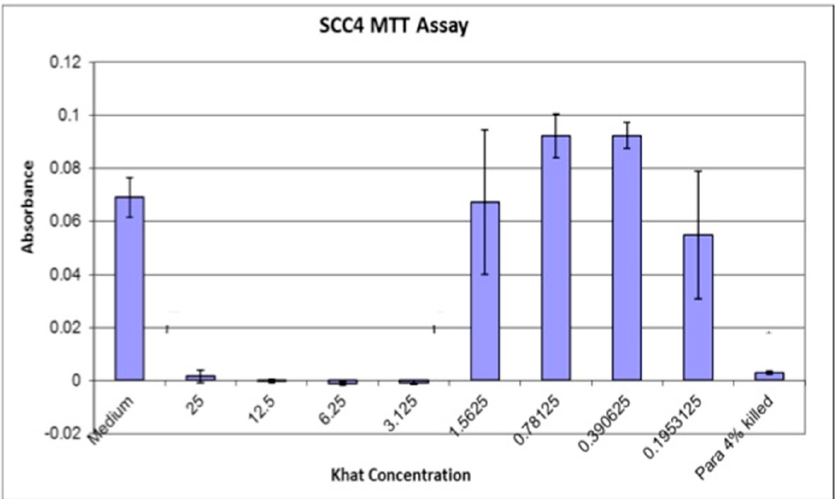
Figure 6. Absorbance from MTT Assay for SCC4 cells treated with different concentrations of Khat solution (25 mg/mL to 0.195 mg/mL). Medium with only SCC4 cells was used as a negative control while 4% paraformaldehyde was used as a positive control, showing complete cell death.